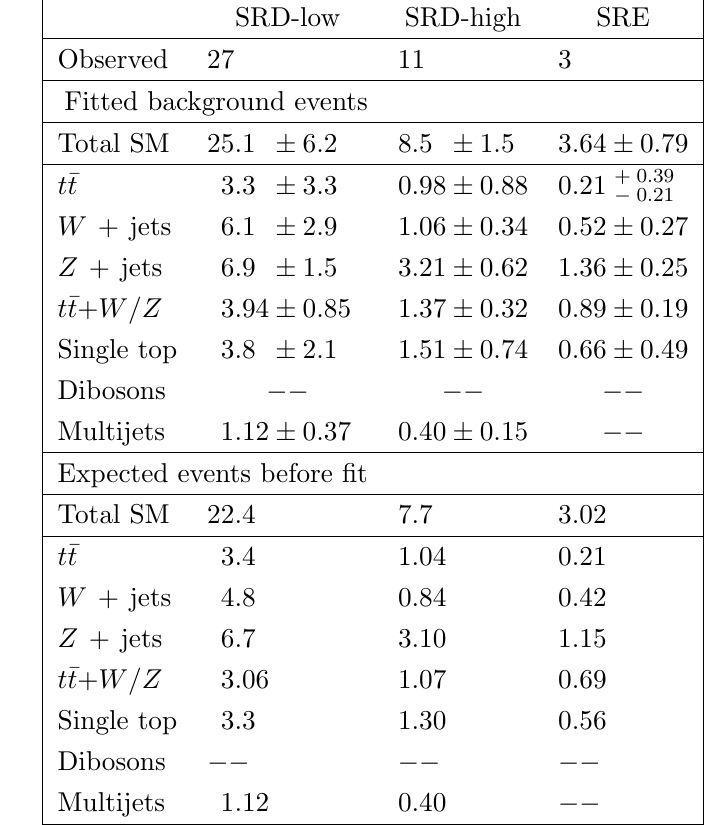
Table 13. Observed and expected yields, before and after the (cid:12)t, for SRD and SRE. The uncertain- ties include MC statistical uncertainties, detector-related systematic uncetainties, and theoretical uncertainties in the extrapolation from CR to